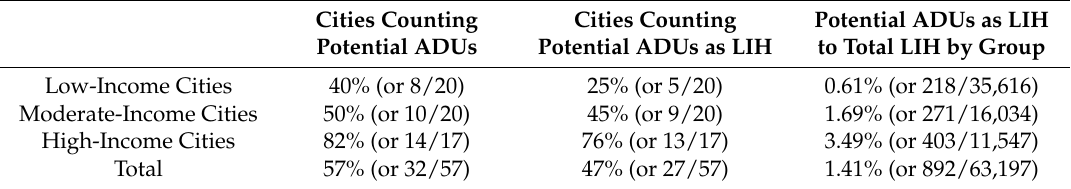
Table 5. Designation of potential towards ADUs overall or low-income housing needs. This table indicates that 82% of high-income cities counted potential ADUs overall and 76% of high-income cities counted potential towards ADUs low-income housing needs. In contrast, 40% of low-income cities counted potential ADUs overall and 25% of low-income cities counted potential ADUs towards low-income housing needs. Notes: ADU = accessory dwelling unit, LIH = low-income